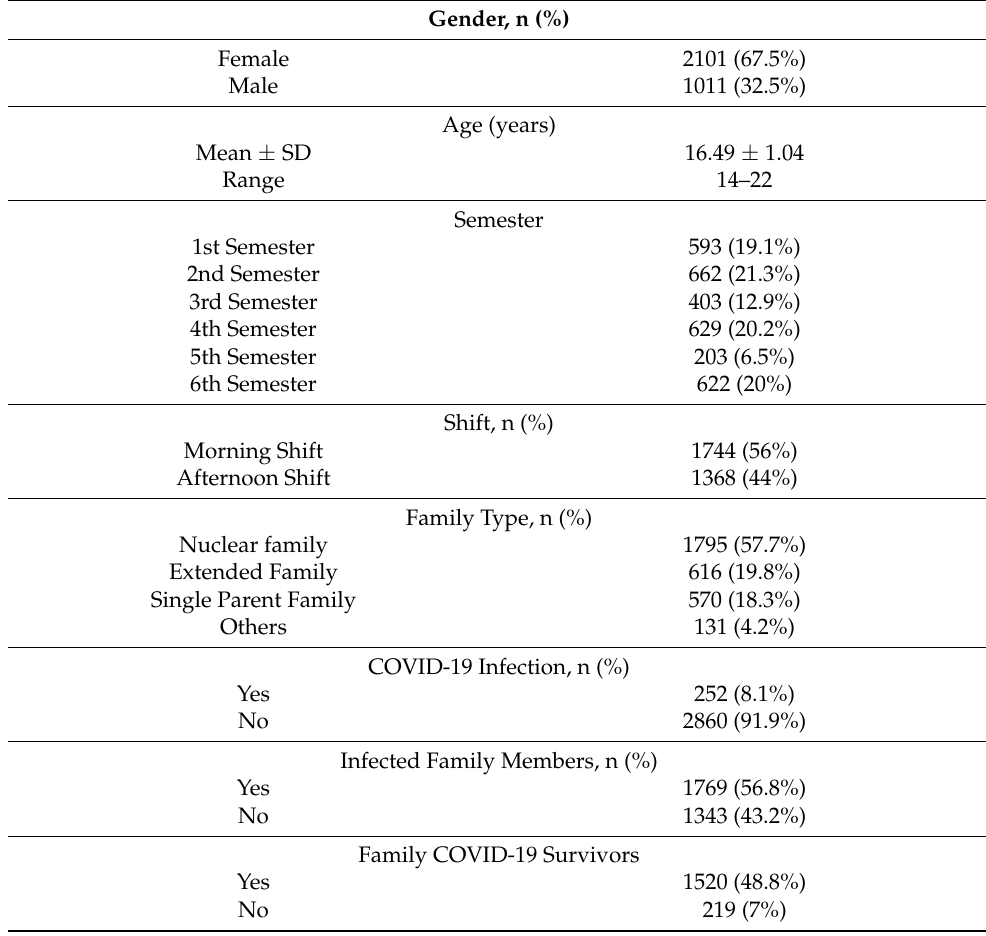
Table 2. Participants’ demographic